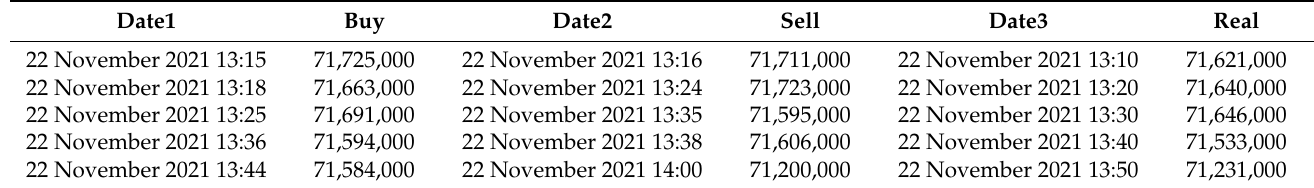
Table 1. Examples of the latest five accurate data per minute for Bitcoin.